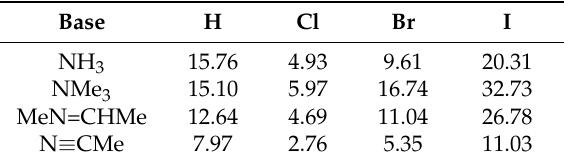
Table 7. NBO values of E(2) (kcal/mol) for charge transfer from N lone pair of base to σ *(C-Z) antibonding orbital of ImZ + Lewis acid.